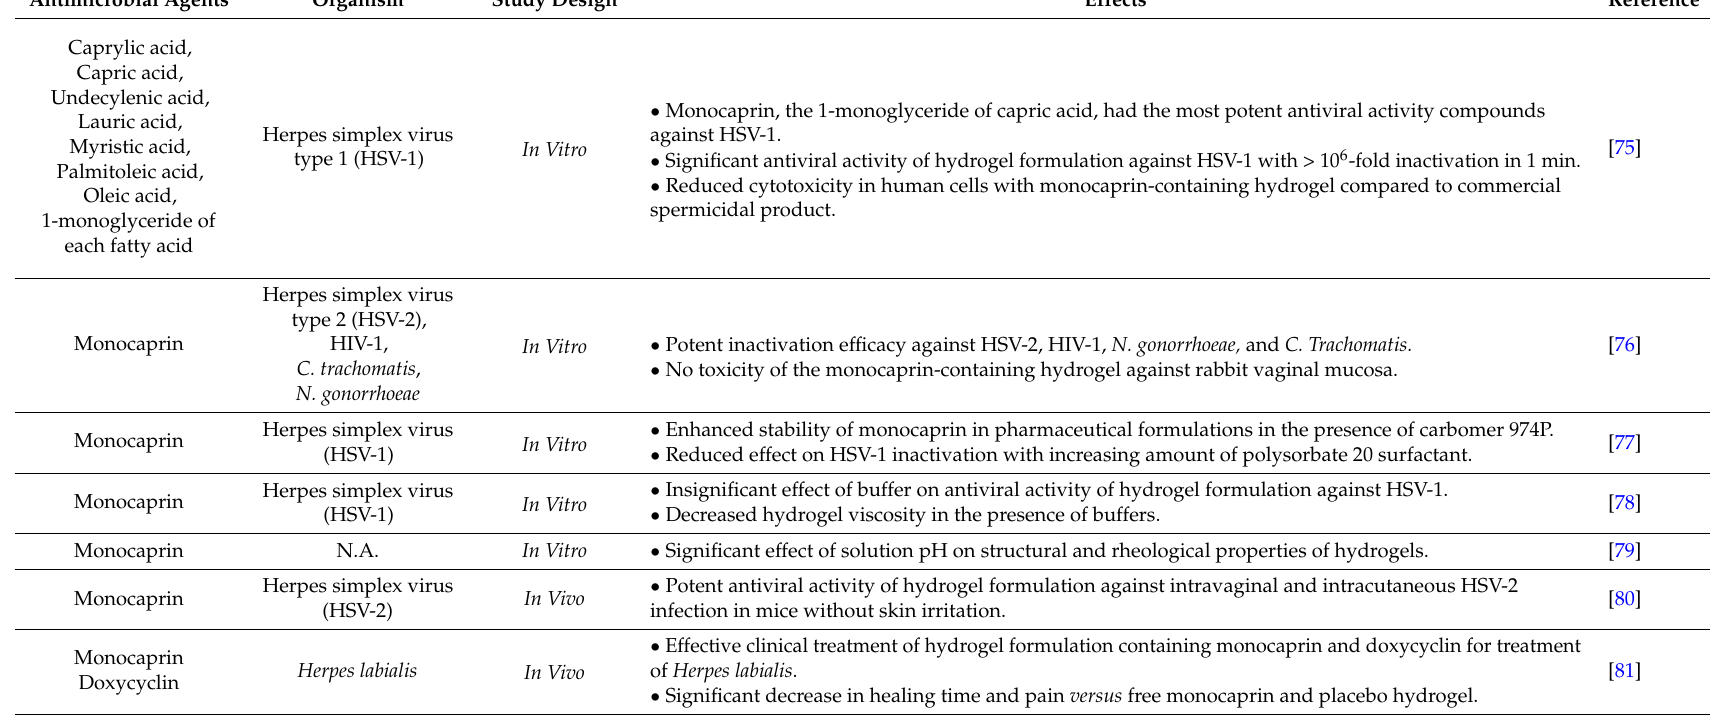
Table 3. Past studies involving antimicrobial properties of hydrogel encapsulation